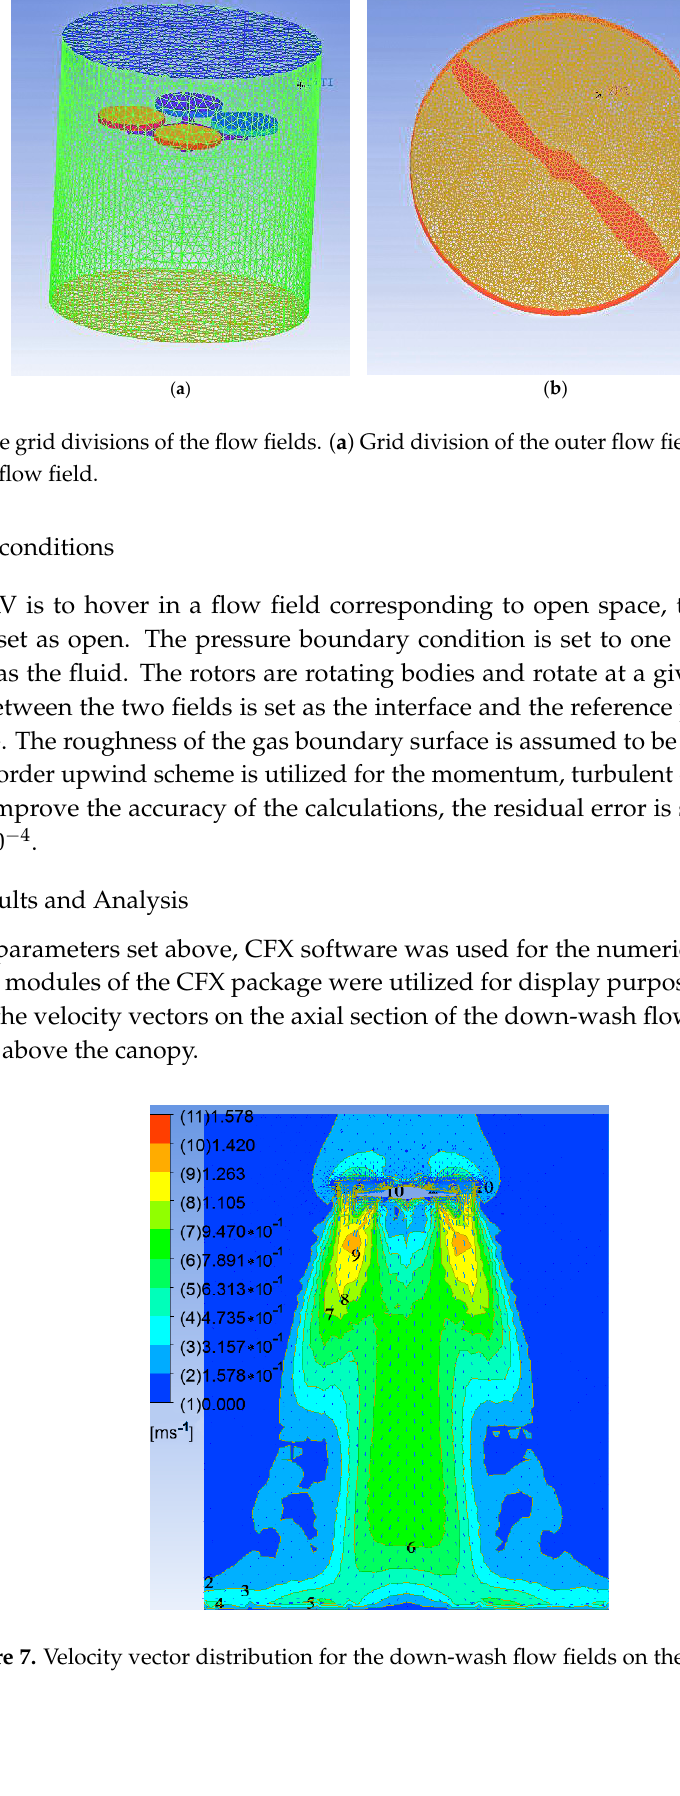
Figure 7. Velocity vector distribution for the down-wash flow fields on the Z - Y section.